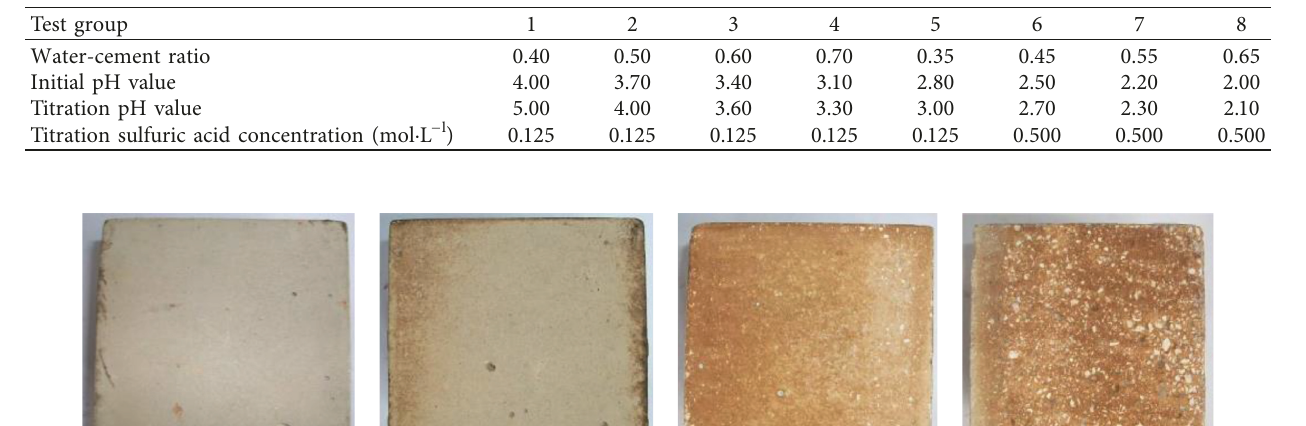
4.00, w / c (cid:30) 0.45. (g) pH (cid:30)